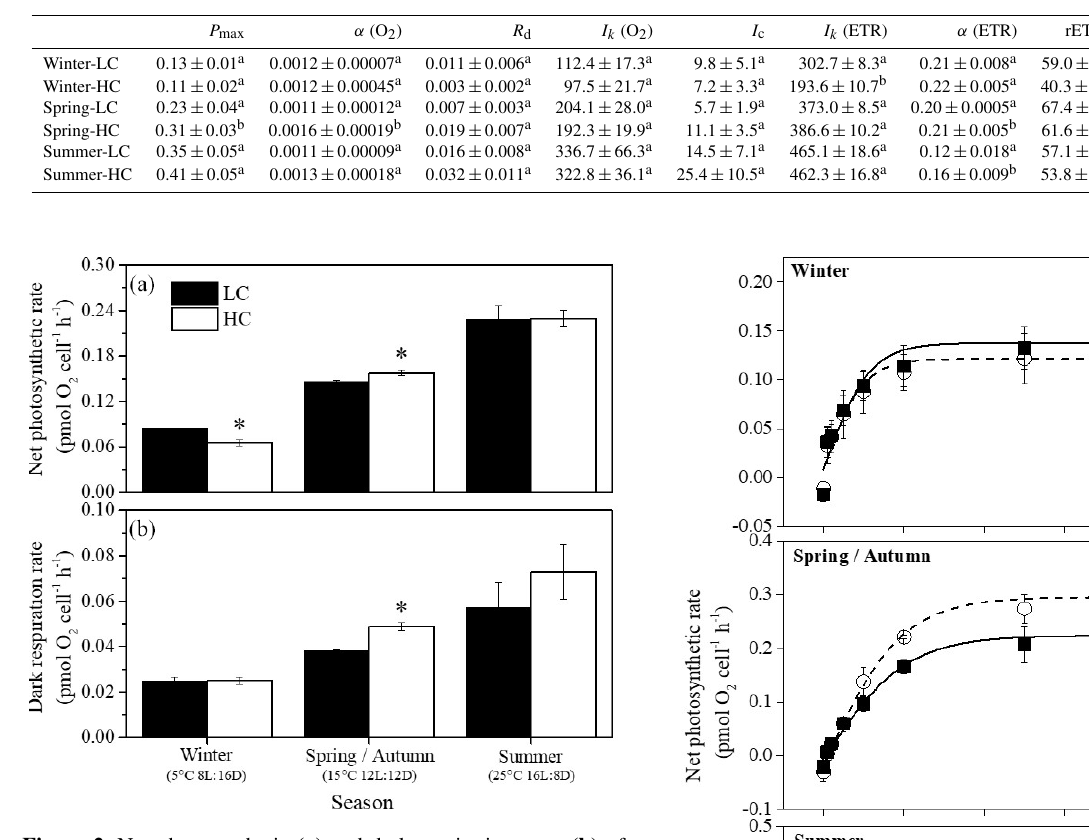
Table 3. Photosynthetic parameters fitted from P ( O – I and rapid light curves for S. costatum acclimated to ambient and elevated p CO 2 2 ) in different seasons. P max (pmolO 2 per cell per hour) is the maximum net photosynthetic rate, α is the photosynthetic efficiency, R d (pmolO 2 per cell per hour) is the dark respiration rate, I k (µmolphotonsm − 2 s − 1 ) is the photosynthetic saturated light intensity, I c (µmolphotonsm − 2 s − 1 ) is light compensation point, rETR max is the maximum relative electron rate and Inh is the relative photoinhibi- tion ratio of rETR. Different superscript letters represent significant differences ( P < 0 . 05) between two CO 2 levels under the same season ( t test).